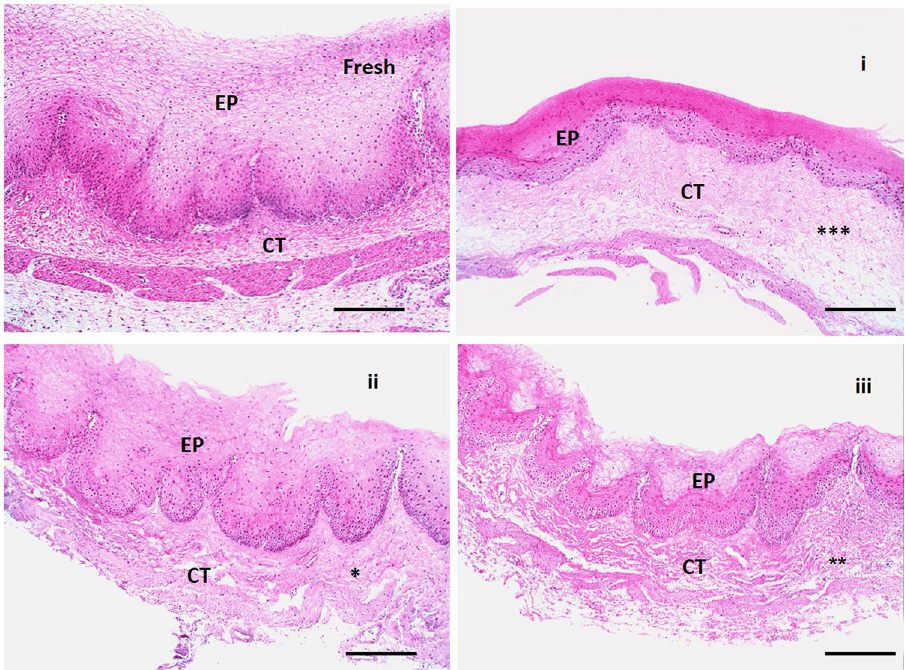
Figure 7. Histopathological pictures of chicken cysts mucosa utilized in ex vivo permeation for a fresh sample as control mucosa, (i) mucosa exposure to VEN solution, ( ii) mucosa exposure to plain NFs, and (iii) mucosa exposure to medicated NFs (F 3 ) using H&E stain X:100 bar 100. (*ρ < 0.05, ** ρ < 0.01, ***ρ < 0.001 vs corresponding value of fresh